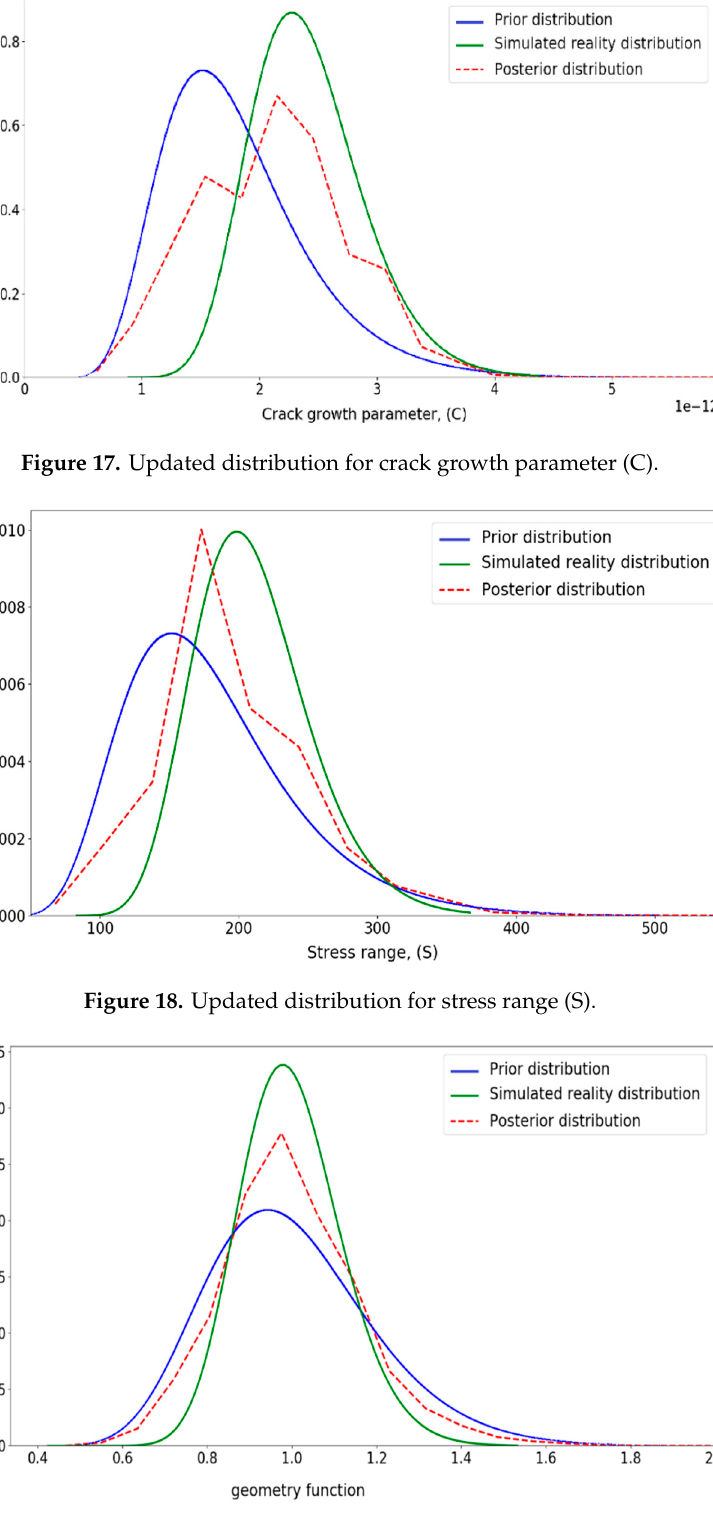
Figure 19. Updated distribution for geometry function (Y)